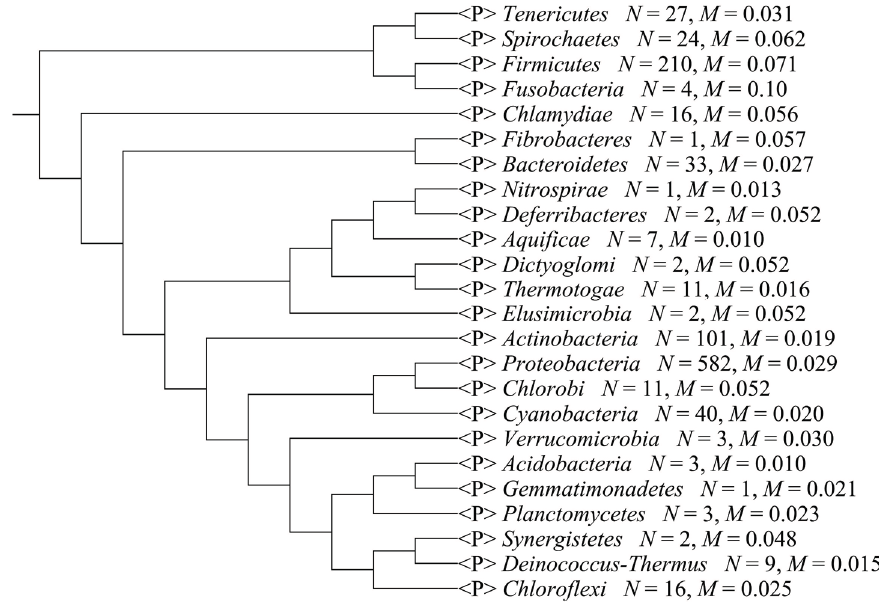
Figure 2. The phylogenetic tree of the 24 phyla. N means the total strains in a phylum, M means the average Score composition bias in a